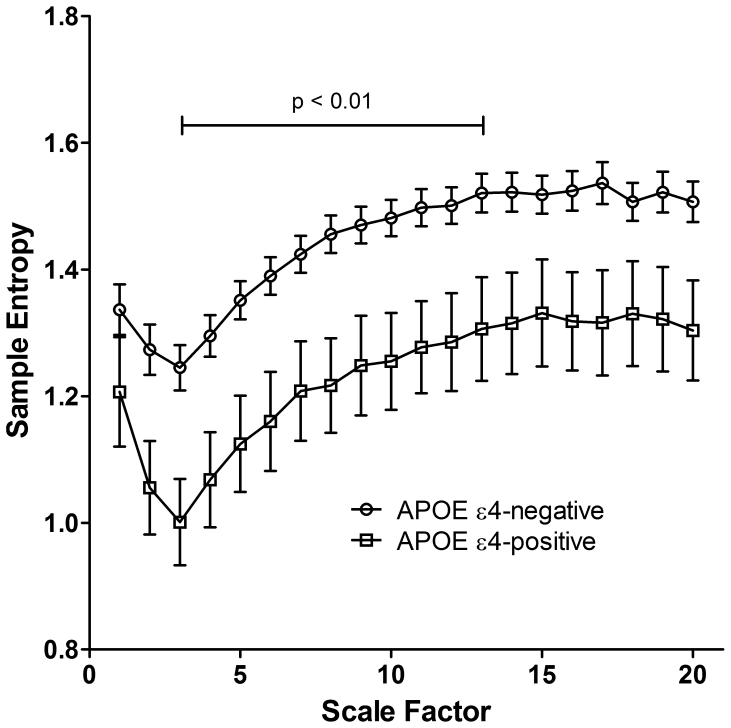
Multiscale entropy analysis by APOE ε4 genotype.Multiscale entropy was derived from two-hours of interbeat interval time series. Symbols represent mean values of entropy for each group and the bars represent the standard error. Parameters of sample entropy calculation are m = 2 and r = 0.15. The sample entropy values for subjects with APOE ε4 allele are significantly lower (p<0.01) on scales between 3 and 13, which are equal to oscillations at period around 10 to 40 heartbeats. p values were computed using Student's t-test at each scale factor.